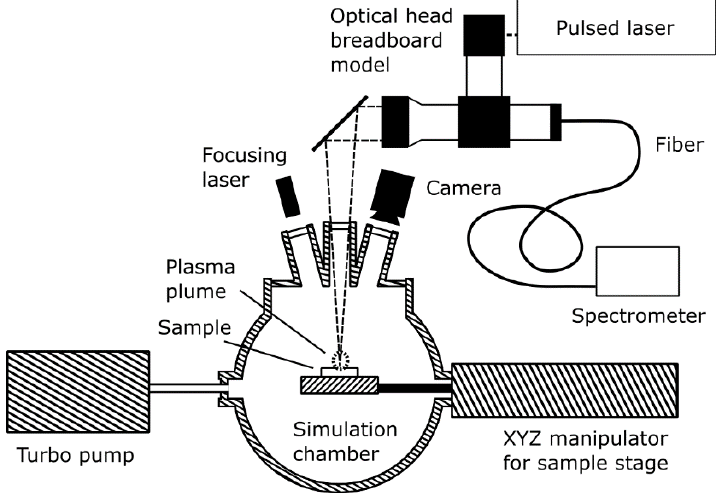
Figure 2. Diagram of the VOILA laboratory demonstration model. The breadboard optical head was built by OHB from COTS components. The laser was developed by LZH in the framework of the LUVMI-X project. Integration of the components and combination with coolable vacuum chamber was performed by and at DLR-OS.